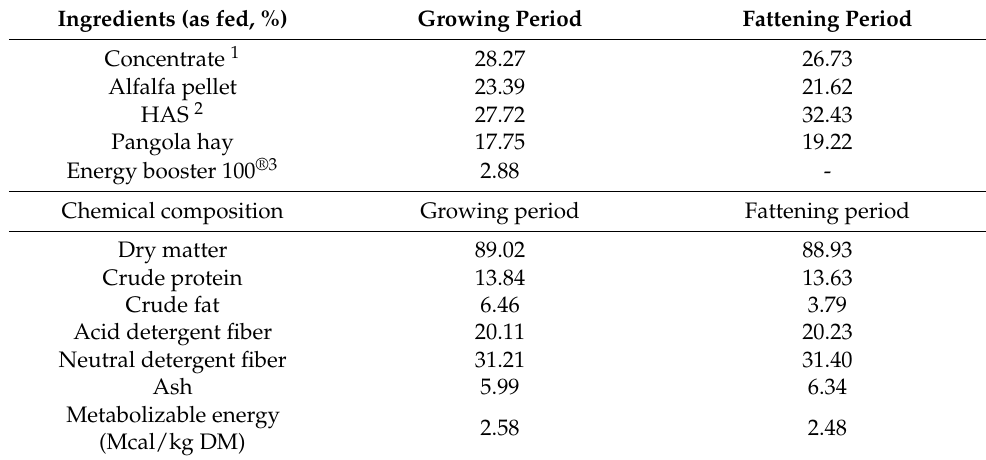
Table 1. The ingredients and chemical composition of experimental diets. Ingredients (as fed, %) Growing